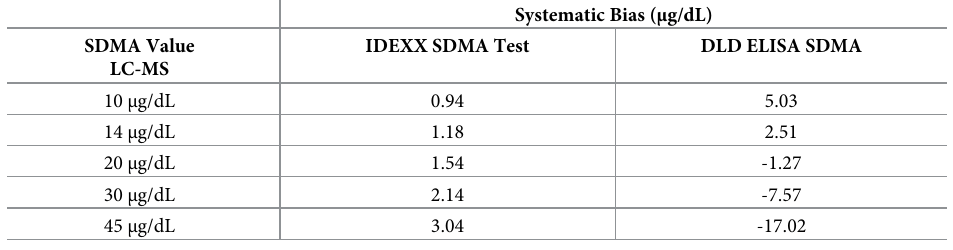
Table 2. Systematic bias calculated from fit lines of IDEXX SDMA Test and DLD ELISA SDMA compared to LC-MS over a clinically relevant range of SDMA concentrations.